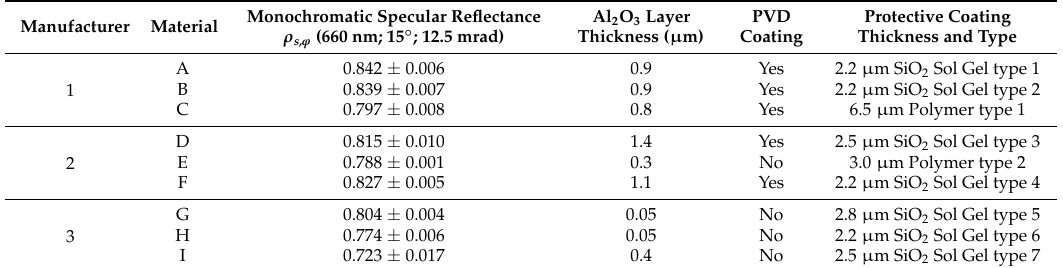
Table 1. Specular reflectance and structure of the different materials tested.